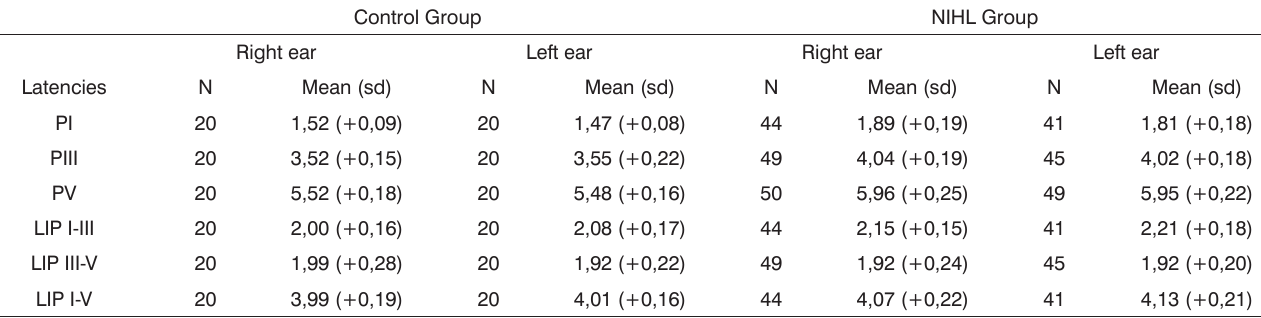
Table 2. Mean and standard deviation of the absolute latencies of PI, PIII and PV and of LIPI-III, LIPIII-V and LIPI-V, according to ear laterality, in both groups.